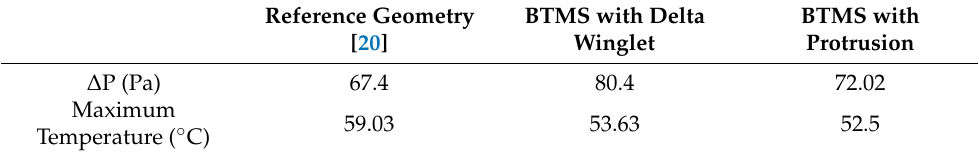
Table 5. Summary of the simulation results for the designed